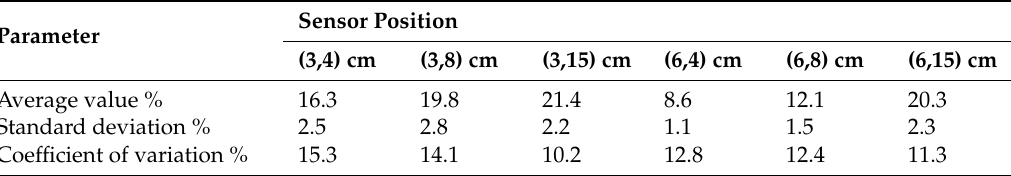
Table 4. Substrate water content analysis at different depth.